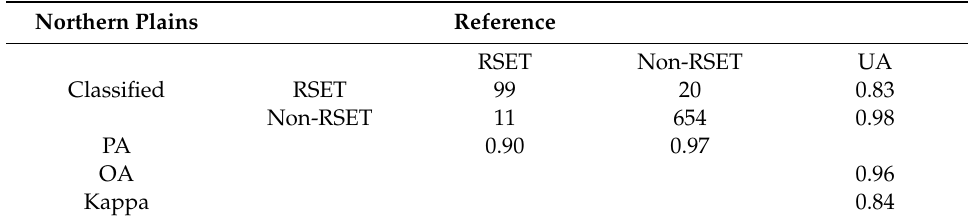
Figure 9. Distribution of validation points in four regions. Table 3. Error matrix for the two classes of RSET (rural settlement) and Non-RSET (including vegetation, water, urban land, and other lands) in the four study